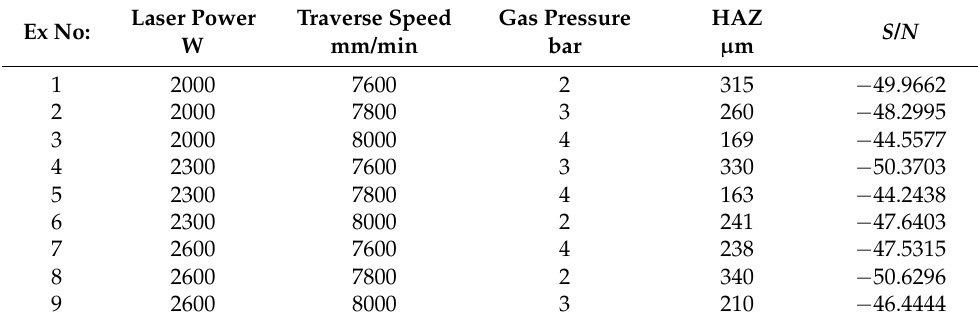
Table 10. L9 array of input parameter levels with the measured HAZ and calculated S / N ratio according to Taguchi methods for 6 mm specimen